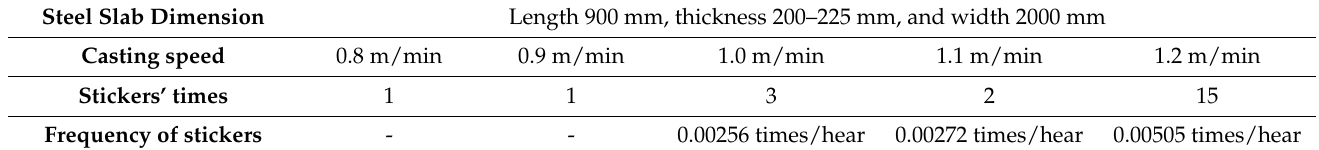
Table 6. Number of stickers at various casting speeds.